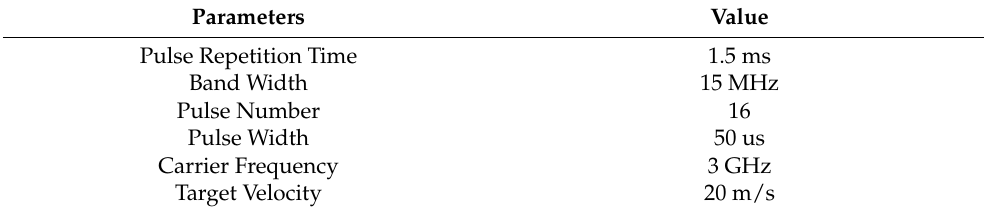
Table 2. Radar parameter configuration.